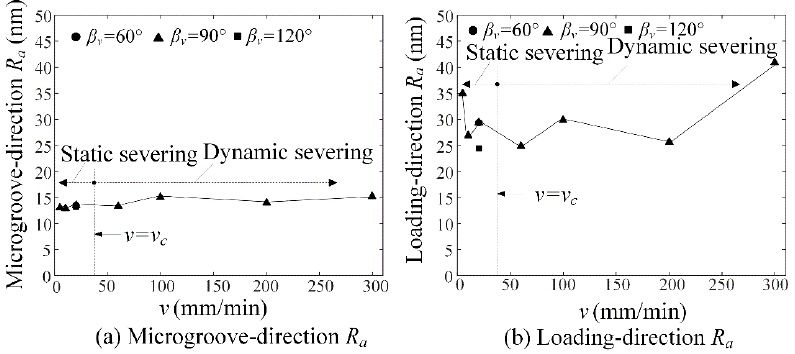
Figure 12. Severing surface roughness R a versus loading rate v : ( a ) microgroove-direction severing roughness and ( b ) loading-direction severing roughness.